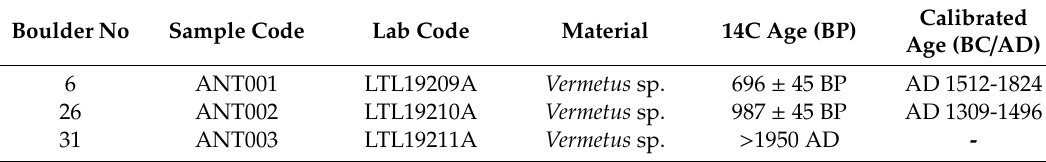
Table 3. Dating results of shell fragments collected on boulders.